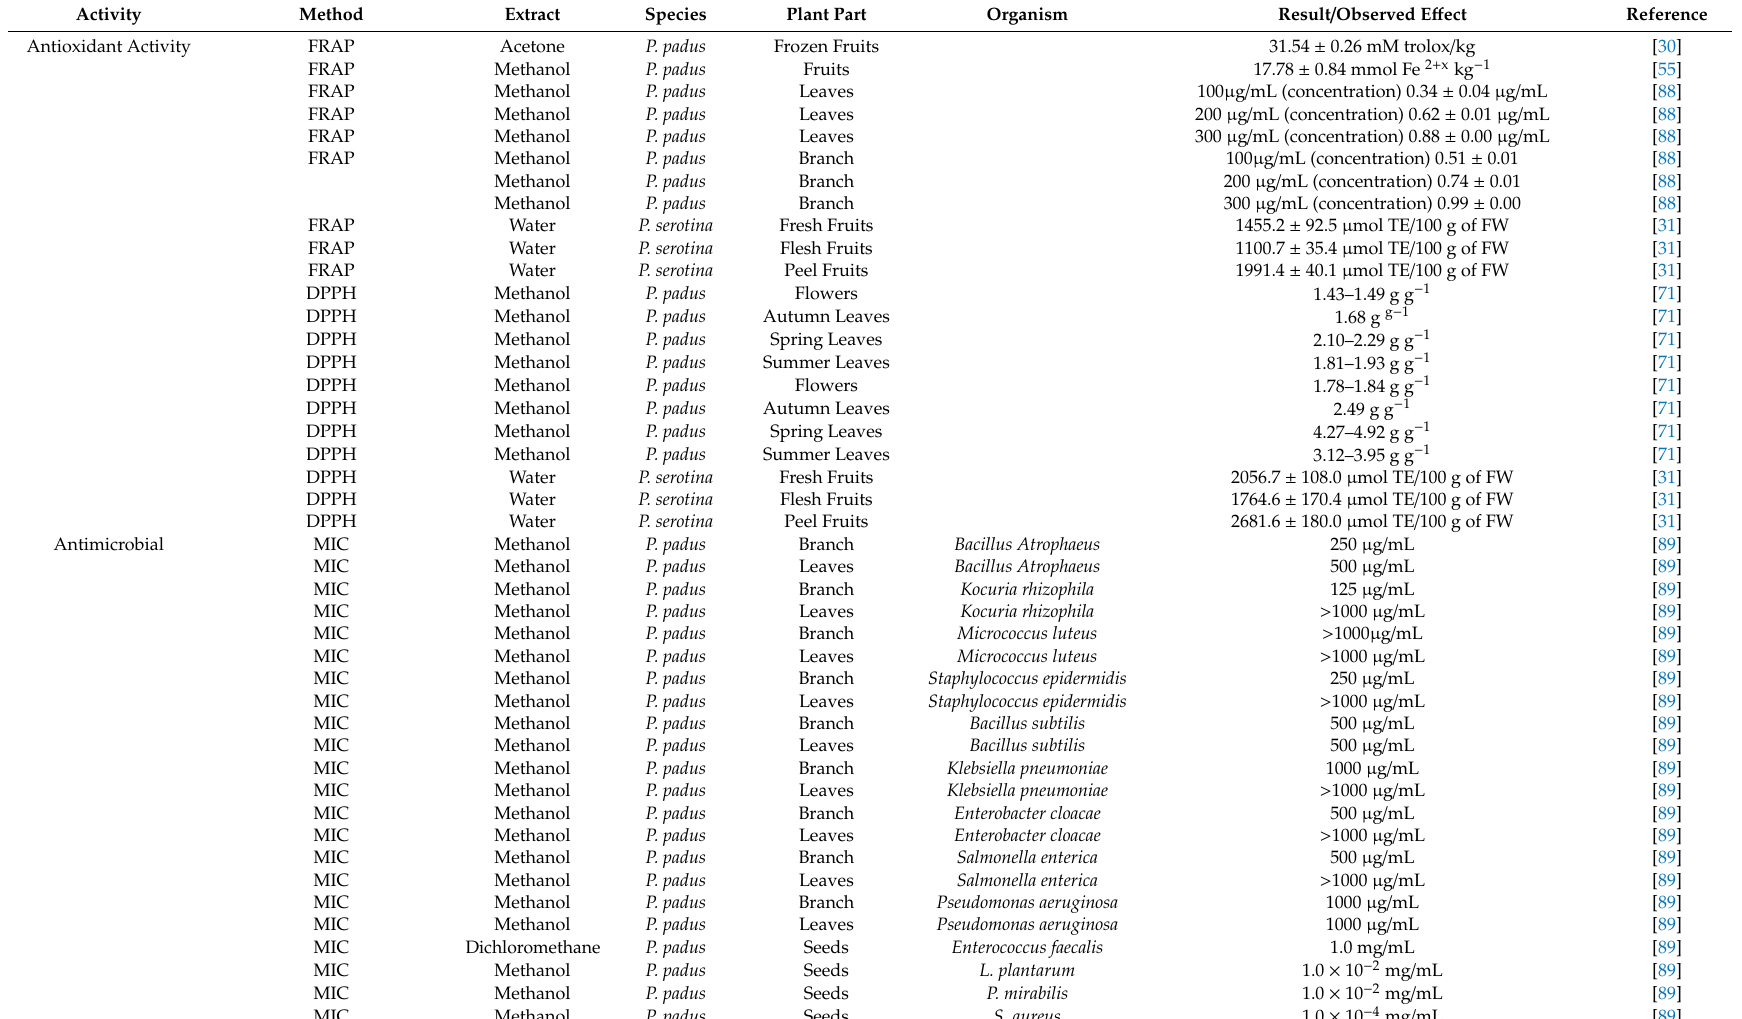
Table 7. In vitro and in vivo activity of P. padus and P. serotina